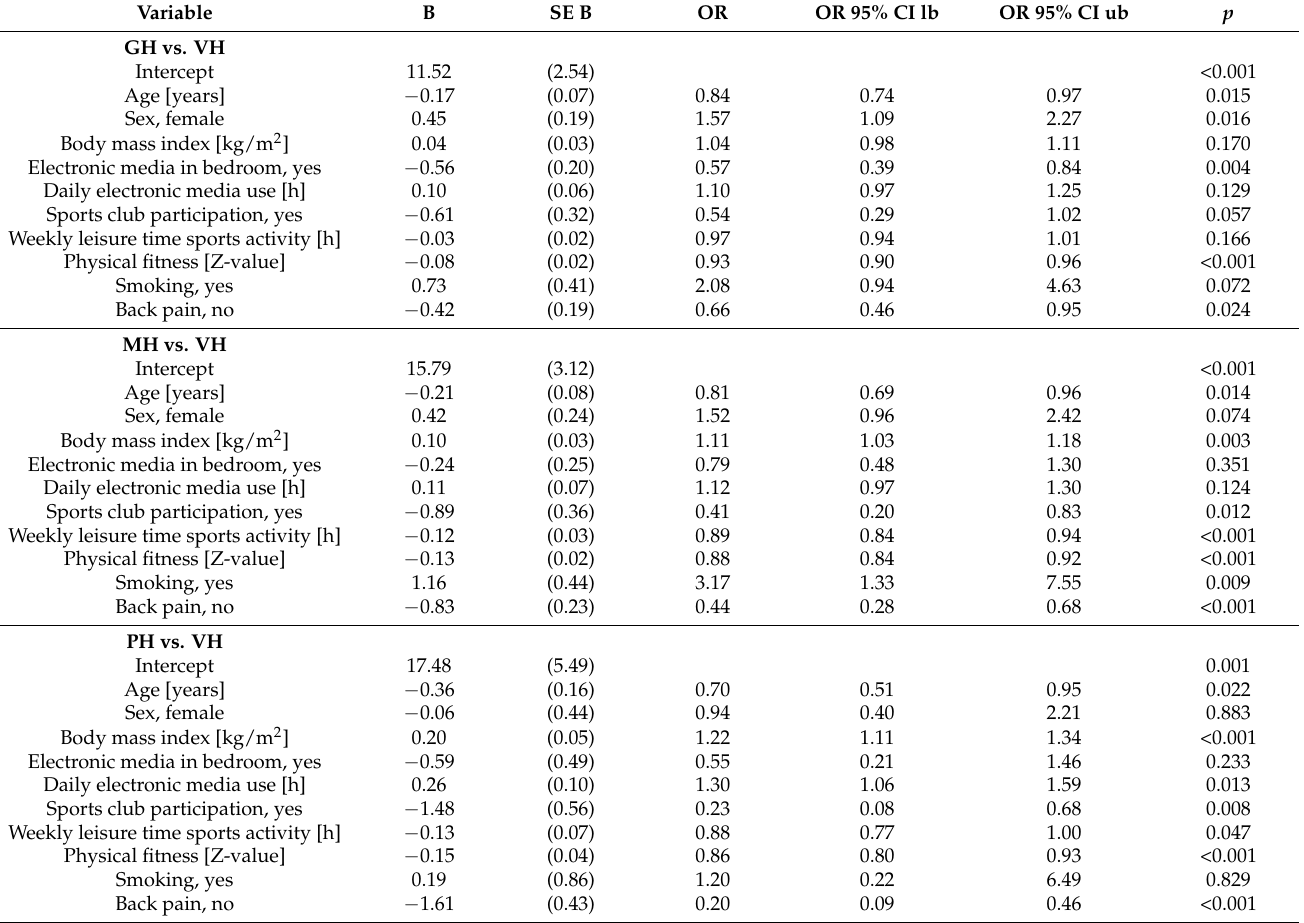
In Table 2, results of the multiple multinomial regression model are presented. Com- pared to the group with very good perceived health (reference group), being female (OR = 1.57) significantly increased the odds for being in the group with good perceived health. Conversely, being older (OR = 0.84), having electronic media in the bedroom (OR = 0.57), showing higher physical fitness (OR = 0.93), and not reporting back pain (OR = 0.66) significantly decreased the odds for being in the group with good perceived health compared to the group with very good perceived health. Table 2. Results of the multiple multinomial regression analysis with the dependent variable per- ceived health